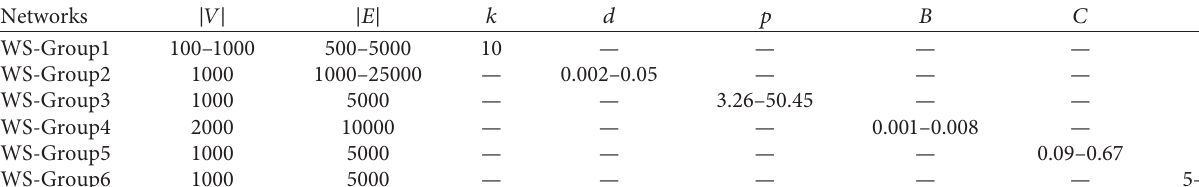
Table 6: Network structure of six groups of WS small-world networks.